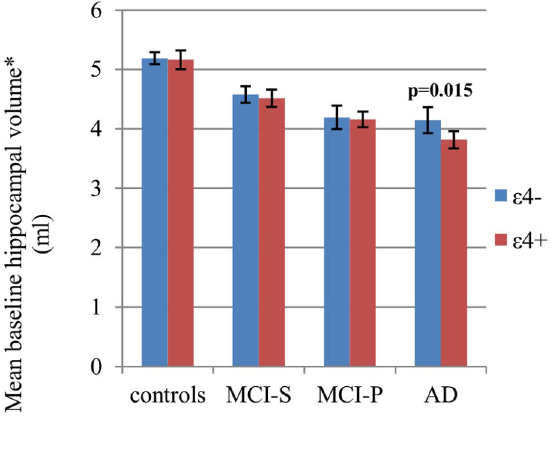
Figure 2. Effect of APOE e 4 on baseline hippocampal volumes.* doi:10.1371/journal.pone.0097608.g002 PLOS ONE |